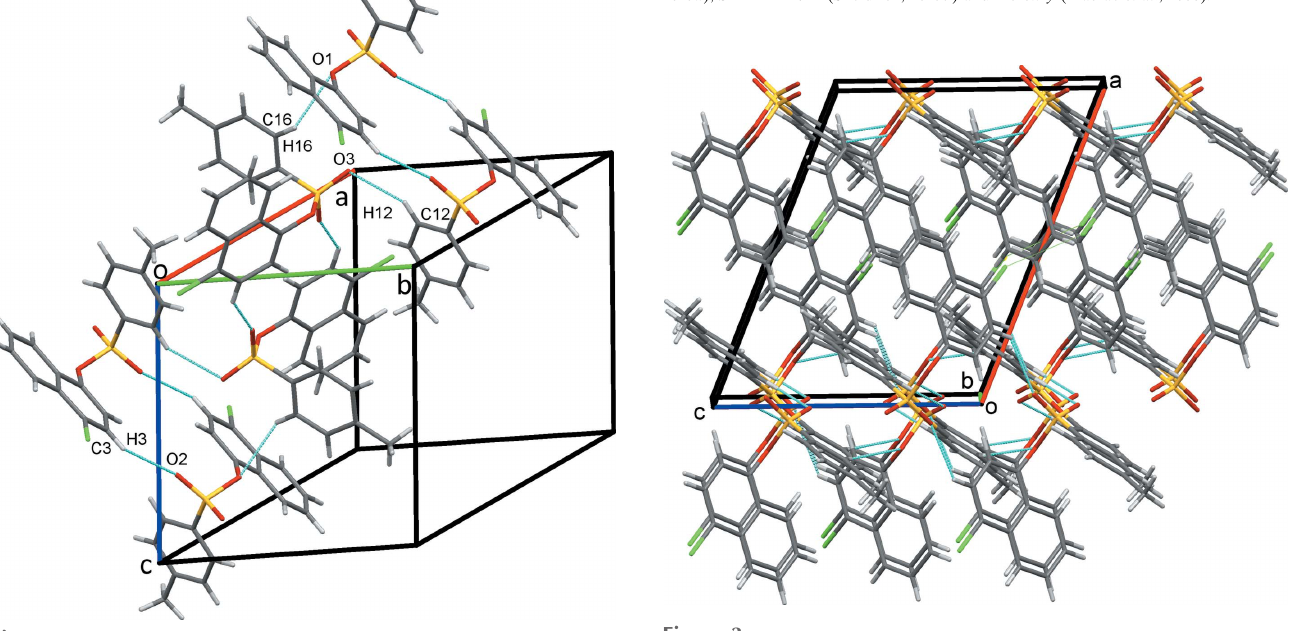
Figure 2 Rows of molecules along the bc diagonal. Hydrogen bonds are shown as blue dashed lines.